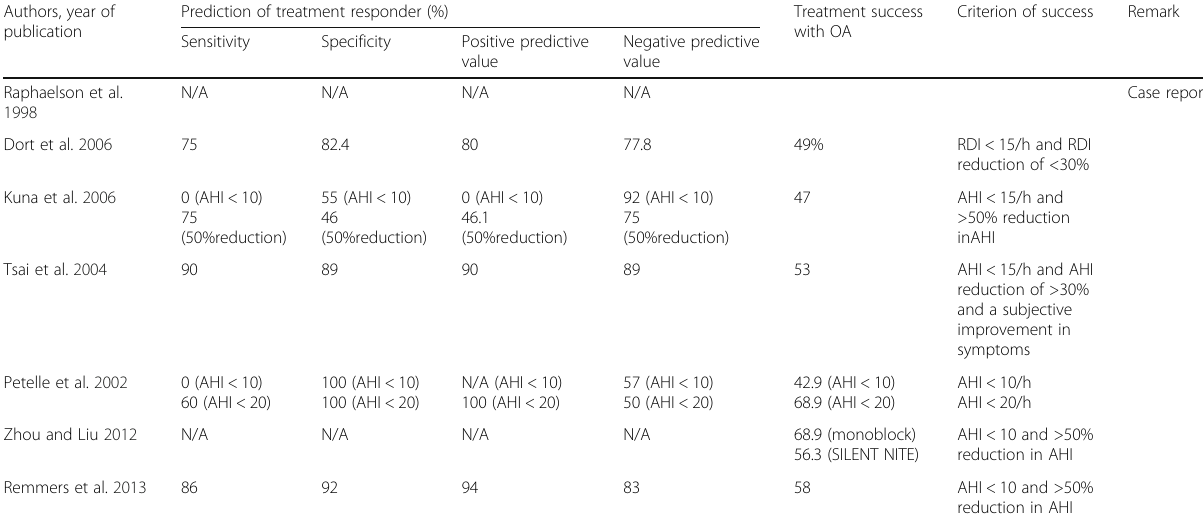
Table 1 Prediction of treatment response with oral appliance